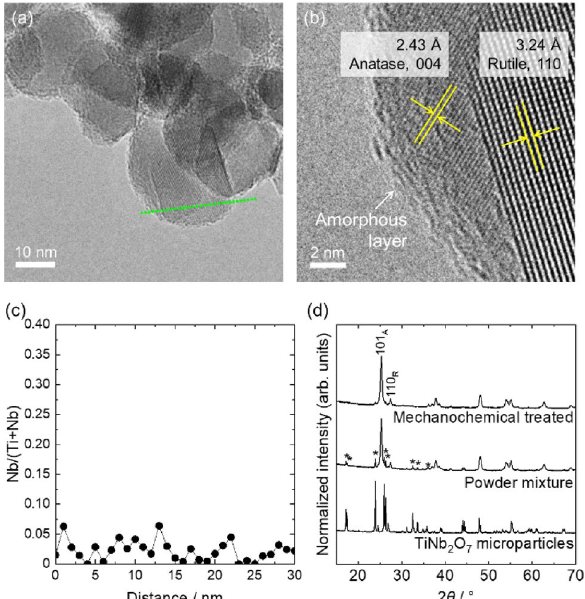
Figure 2. ( a , b ) TEM images and ( c ) Nb/(Ti + Nb) calculated from STEM-EDS line scan of NTO-5-dry. Green dots in ( a ) are scanned points of STEM-EDS shown in ( c ). ( d ) XRD patterns of TiNb 2 O 7 microparticles, powder mixture of pristine TiO 2 and TiNb 2 O 7 and mechanochemical treated powder (nominal Nb/(Ti + Nb) = 0.05). * TiNb 2 O 7 ; JCPDS